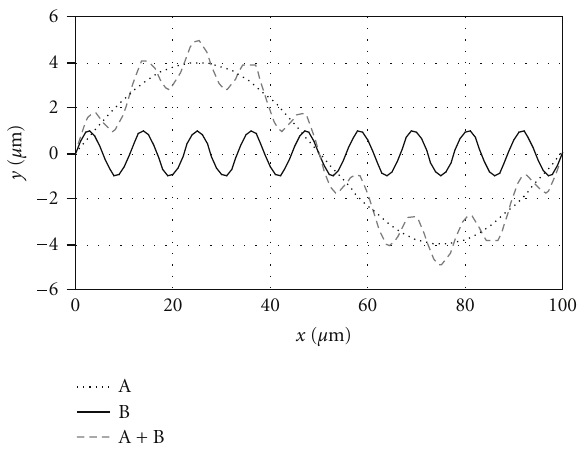
Figure 1: Surface roughness models used.